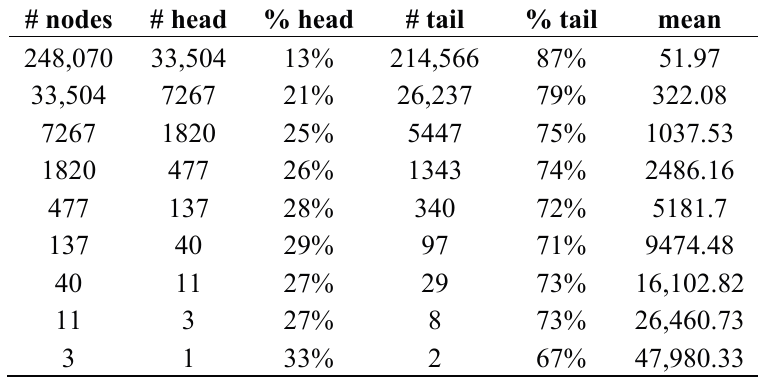
Table 4. Head/tail breaks statistics for node degree of co-contribution network in 2013. #